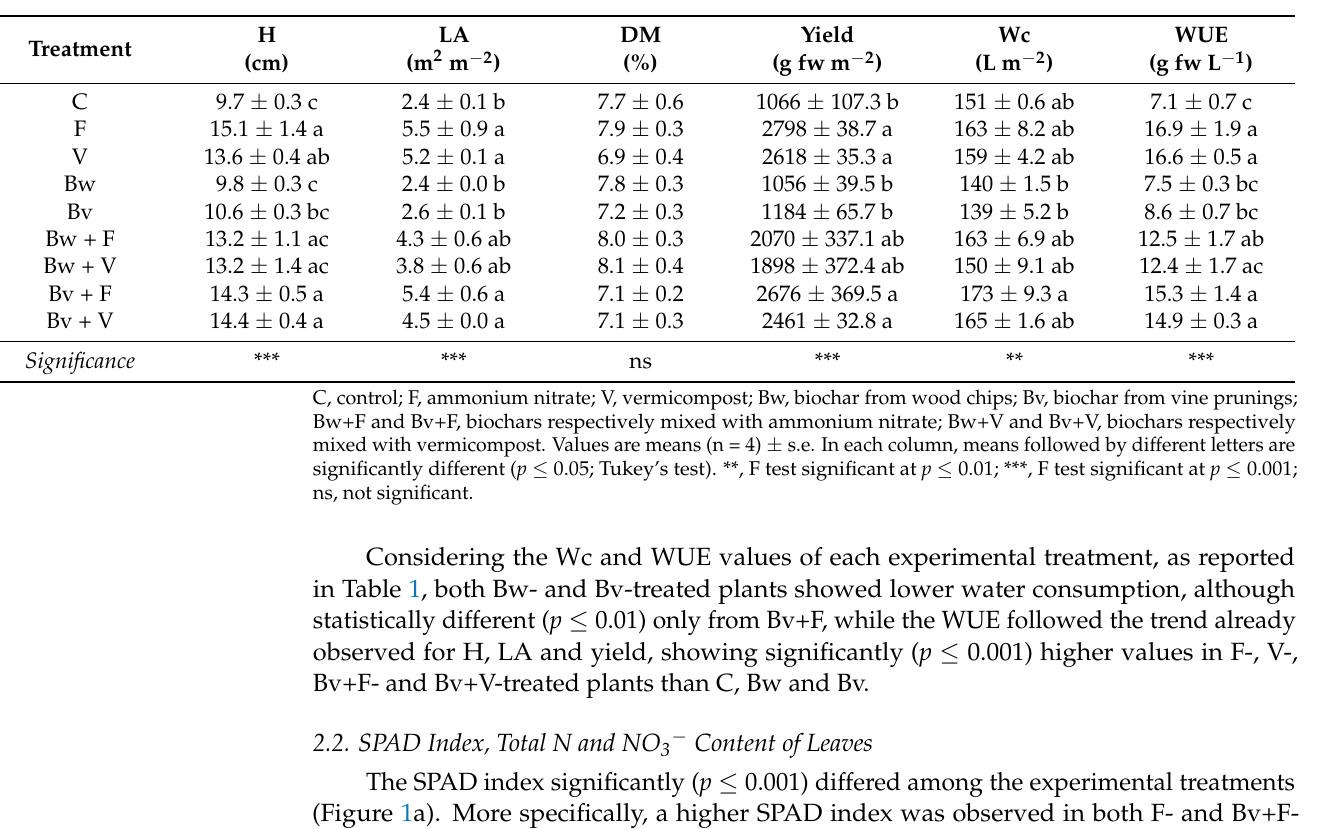
Table 1. Plant height (H, cm), leaf area (LA, m 2 m − 2 ), leaf dry matter (DM, %), total yield